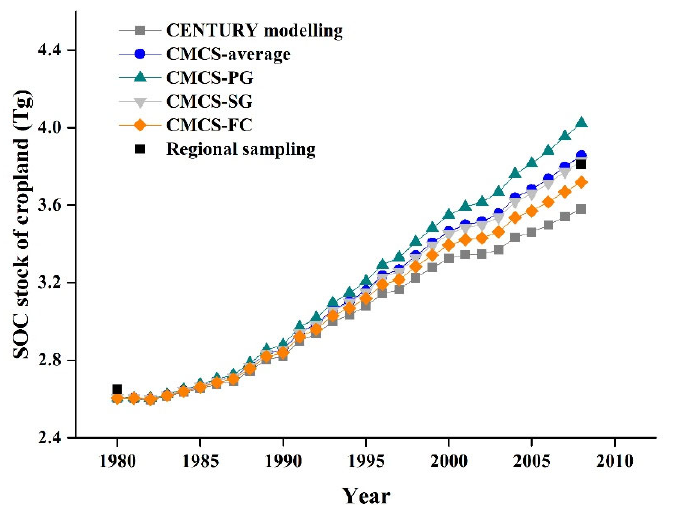
Figure 6. Comparison of soil organic carbon (SOC) stocks estimated by CENTURY modeling, CMCS framework, and regional soil sampling in cropland of Cangshan County. CMCS represented the framework combining CENTURY modeling and chronosequences sampling. PG, SG, and FC repre- sent perennial greenhouse, seasonal greenhouse, and field cultivation, respectively.